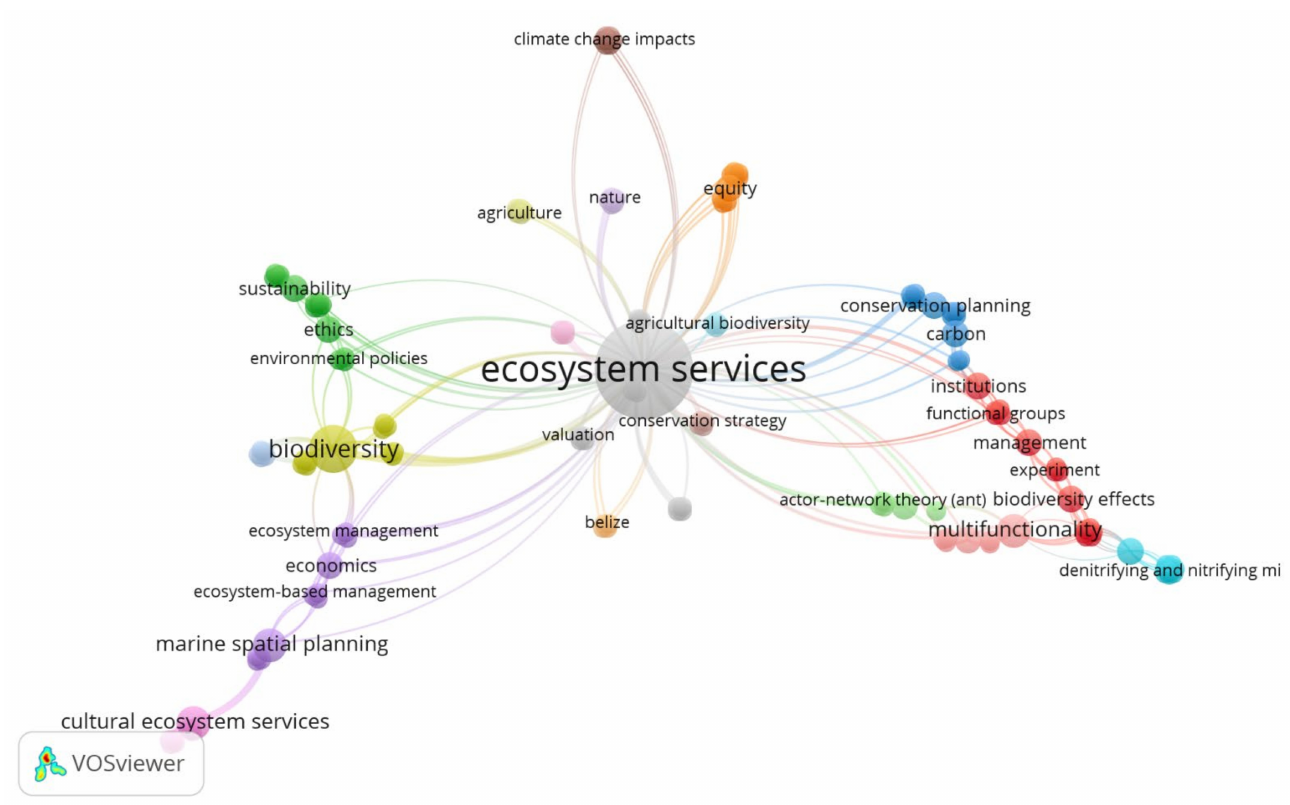
Figure 3. Co-occurrence network (author keywords) related to ecosystem services research in Web of Science Core Collection (WoSCC) database obtained by the highly cited journals from 2000 to 2020. Note: The threshold value = 1, applied for highly cited articles of 128, resulting in 156 keywords distributed among 22 clusters. The bubble size shows the total number of highly cited articles, the line thickness shows the linkage’s strength, and the color shows the